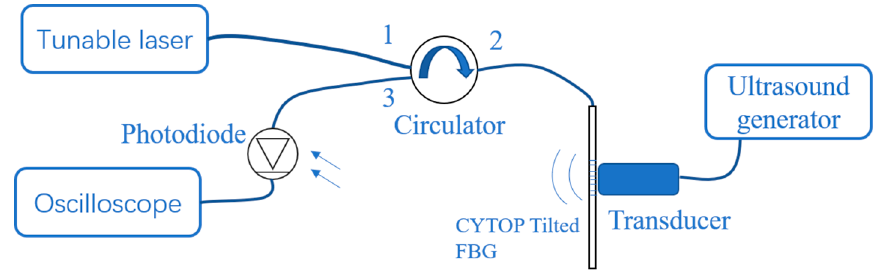
Figure 15. Ultrasonic detection setup.